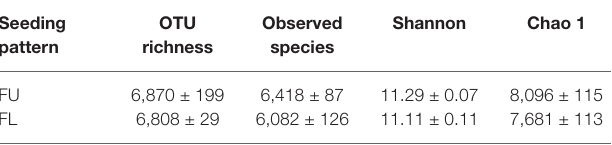
97% similarity levels.